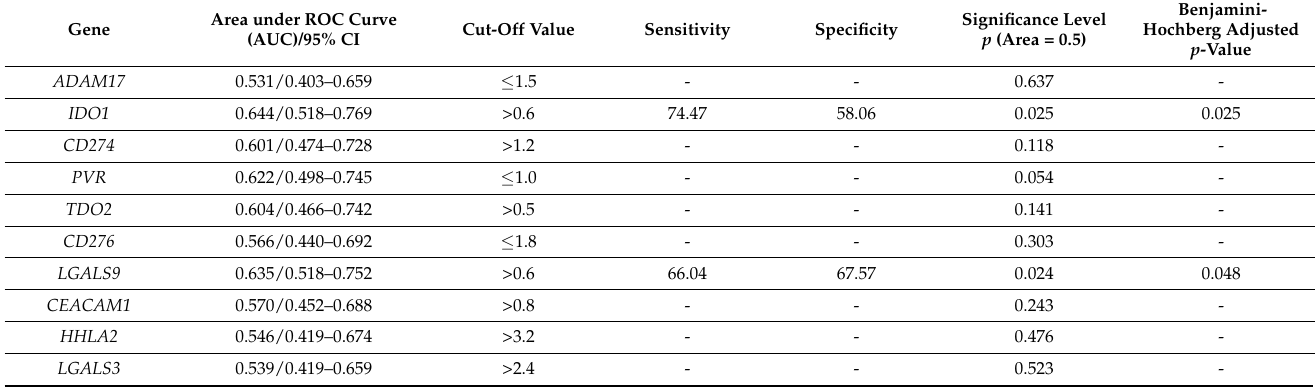
Table 4. The relationship of gene expression with the degree of tumor differentiation—ROC analysis. Area under ROC Curve (AUC)/95% CI